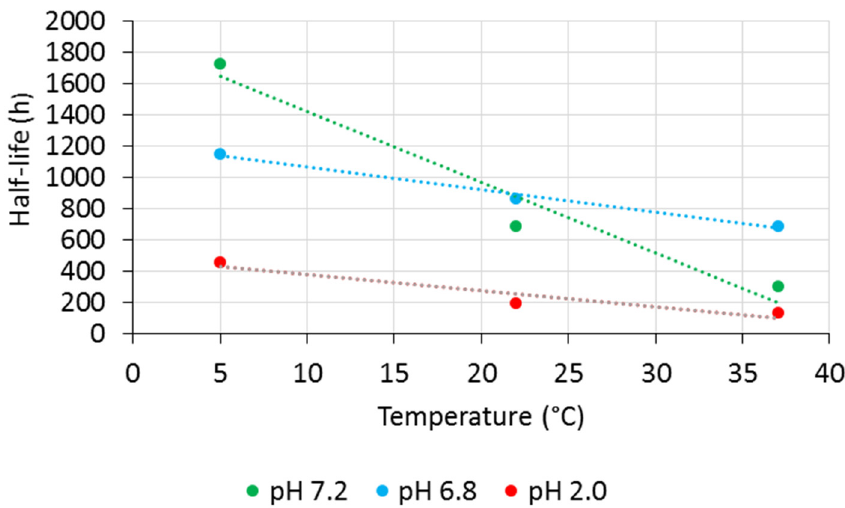
Figure 6. RSVTR half-life vs. temperature of incubation at different pH values.